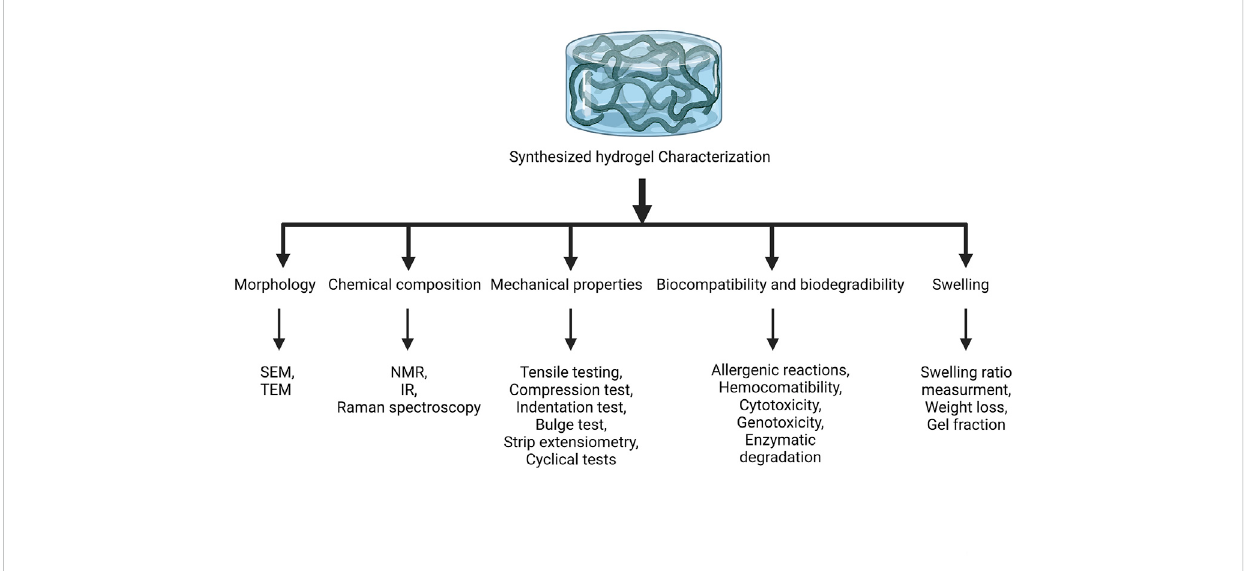
FIGURE 1 Characterization of hydrogels. The synthesized hydrogels are characterized by evaluating their morphology, chemical composition,